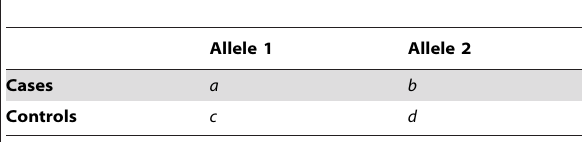
Table 1. 2 6 2 contingency table of allele